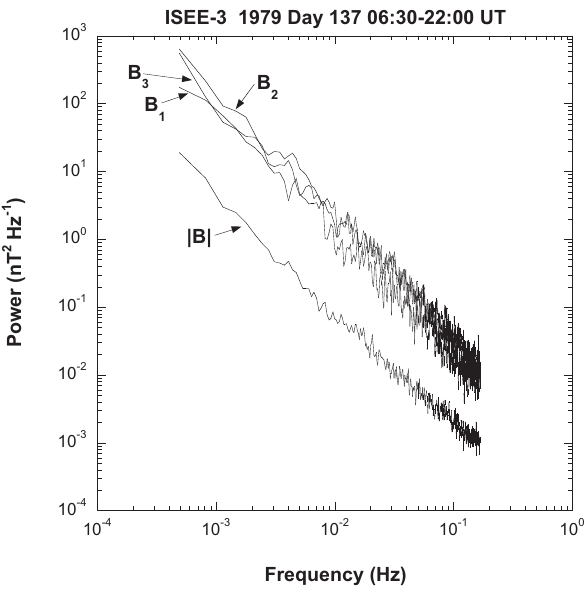
Fig. 3. Magnetic power spectra for the 17 May 1979 event. Com- ponents 1 and 2 are the two transverse components of the field.